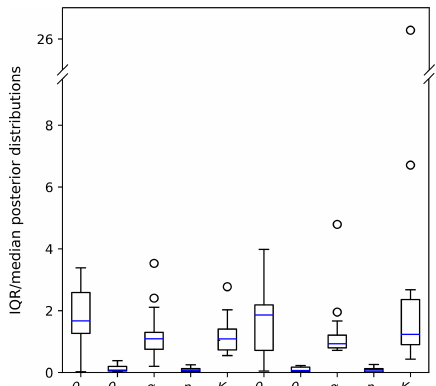
Figure 3. Box plots of estimated parameter uncertainties (index 1 denotes the upper soil layer and index 2 denotes the lower soil layer) from all 14 sites, as ratios between the 95% interquantile range (IQR) and median